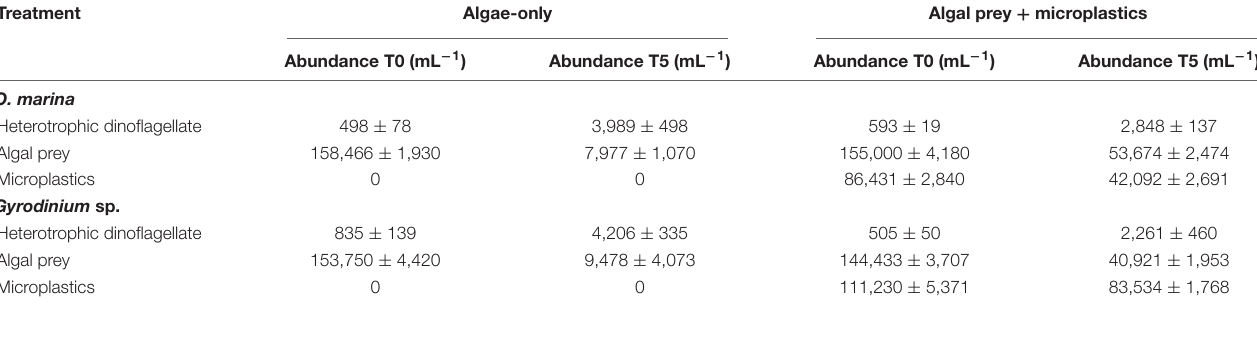
TABLE 1 | Initial (T0) and final (T5) abundances (mL − 1 ) of heterotrophic dinoflagellates, algal prey, and microplastics in each treatment of the 5-day microplastic ingestion experiments. Treatment